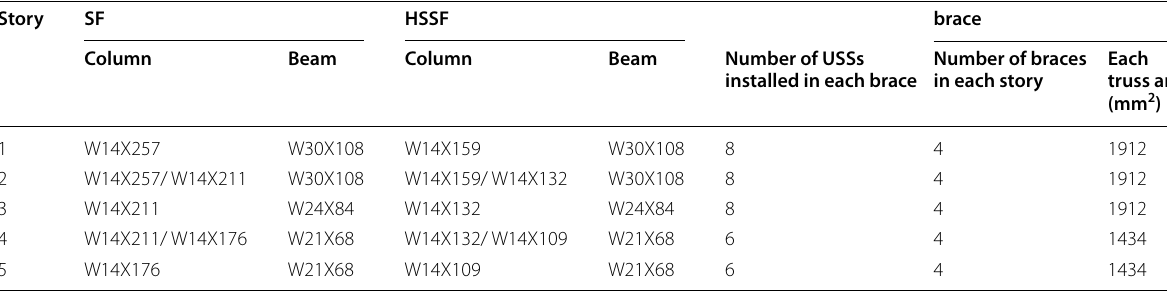
Table 7 Basic information of studied frames